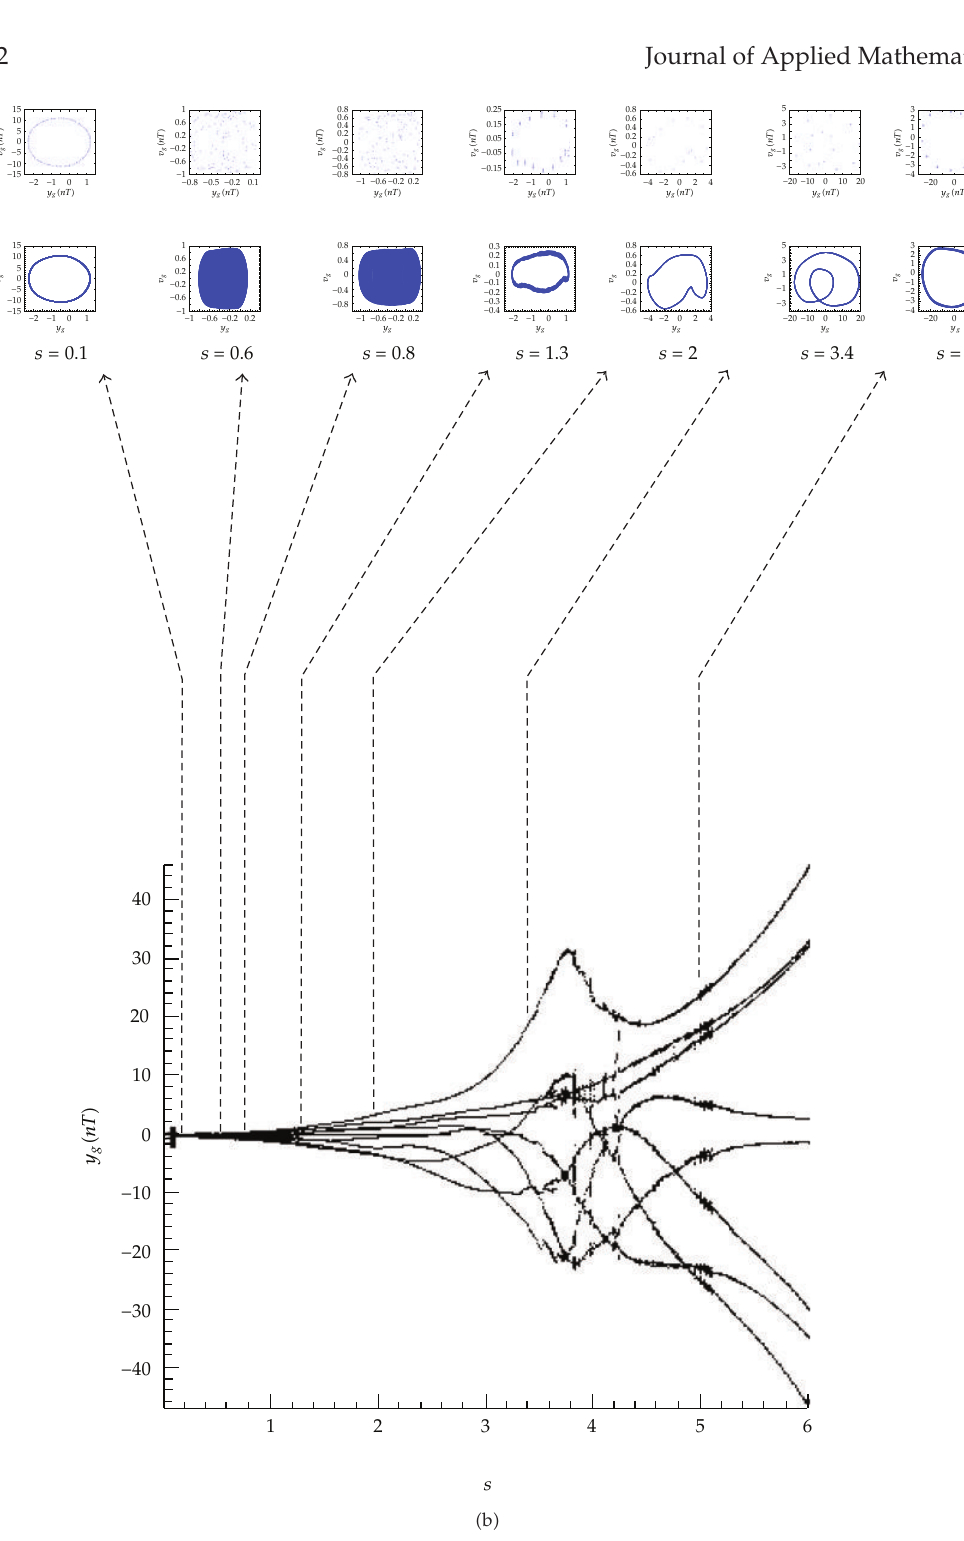
Figure 6: Bifurcation diagrams of gear-bearing system using dimensionless rotational speed ratio, s , as bifurcation parameter for non-Newtonian lubricating fluid with l ∗ (cid:9) 0 .